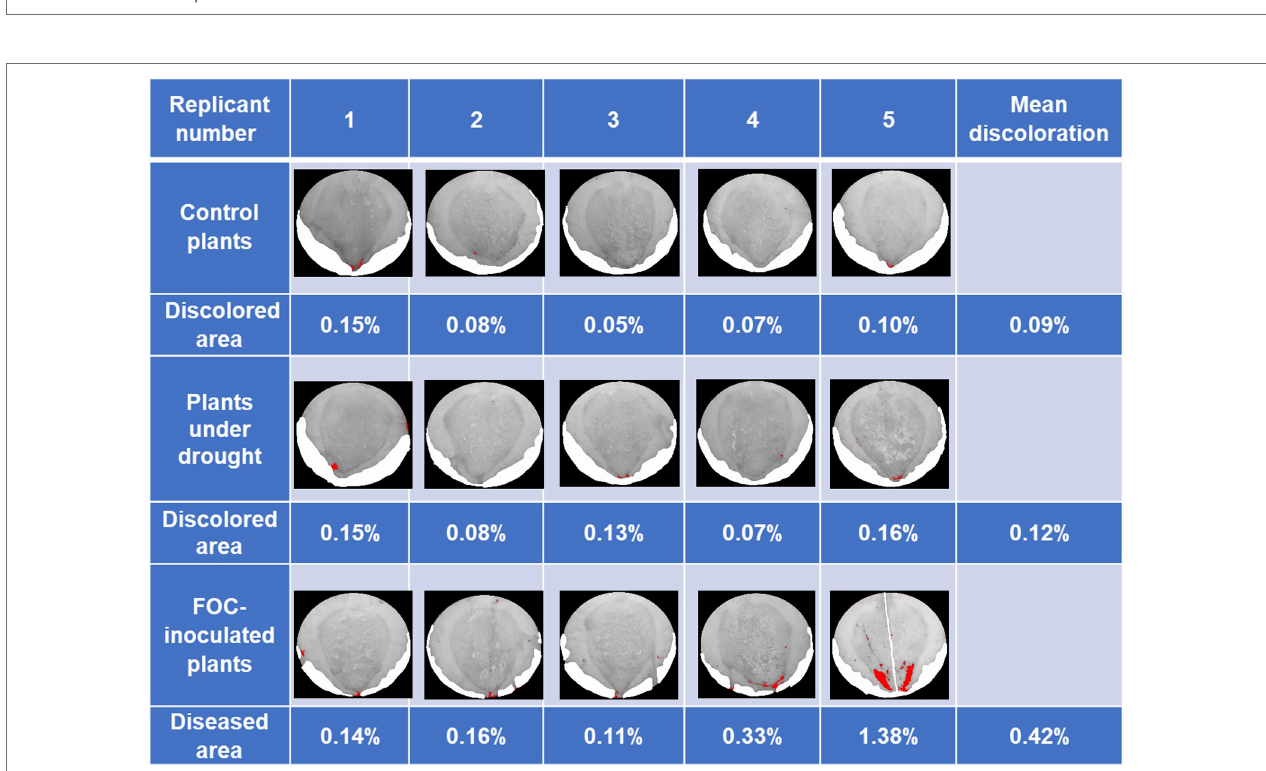
FIGURE 2 | Banana Fusarium symptom development in pseudostem cross-sections during the second trial at 79 days after inoculation (DAI). Pure white areas are cover for areas in the image that art not part of the pseudostem. Percentage of diseased areas (denoted by large continuous red areas in the images) was measured in FOC-inoculated plants using ImageJ.JS software, showing discoloration caused by disease infection. Red areas were shown in the Control and Drought group due to shadow, soil particulate, and other factors darkening parts of the images because ImageJ.JS software only distinguishes color by